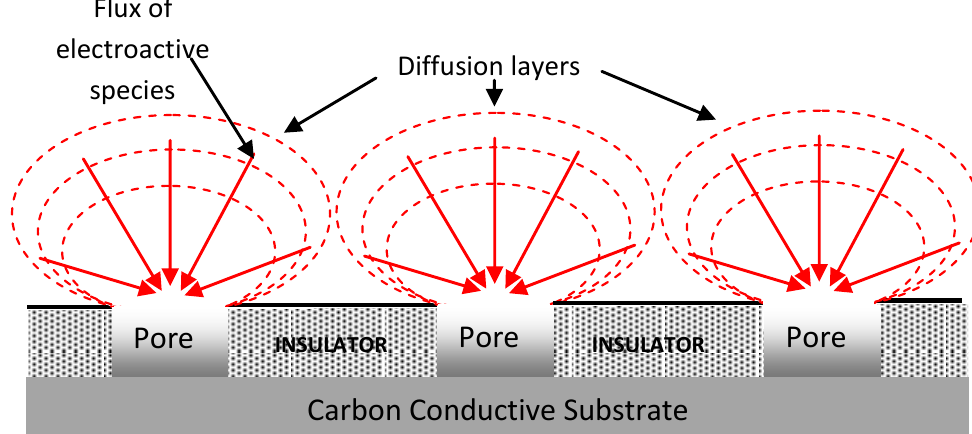
Figure 1. Schematic representation of diffusion at a microelectrode